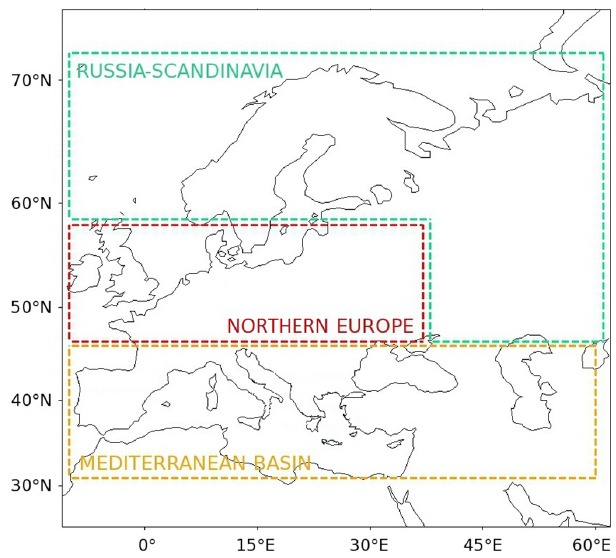
Figure 1. The Euro-Mediterranean area (11 ◦ W–62 ◦ E, 25 ◦ N– 75 ◦ N) considered in this study and the three subregions: Mediter- ranean Basin, northern Europe, and